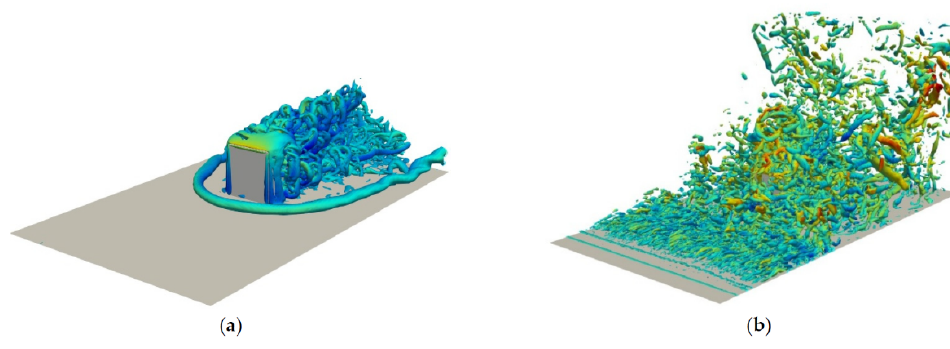
Figure 4. The vertical airflow structures in the presence of fire ( b ) and without ( a ) [33] (p. 11).